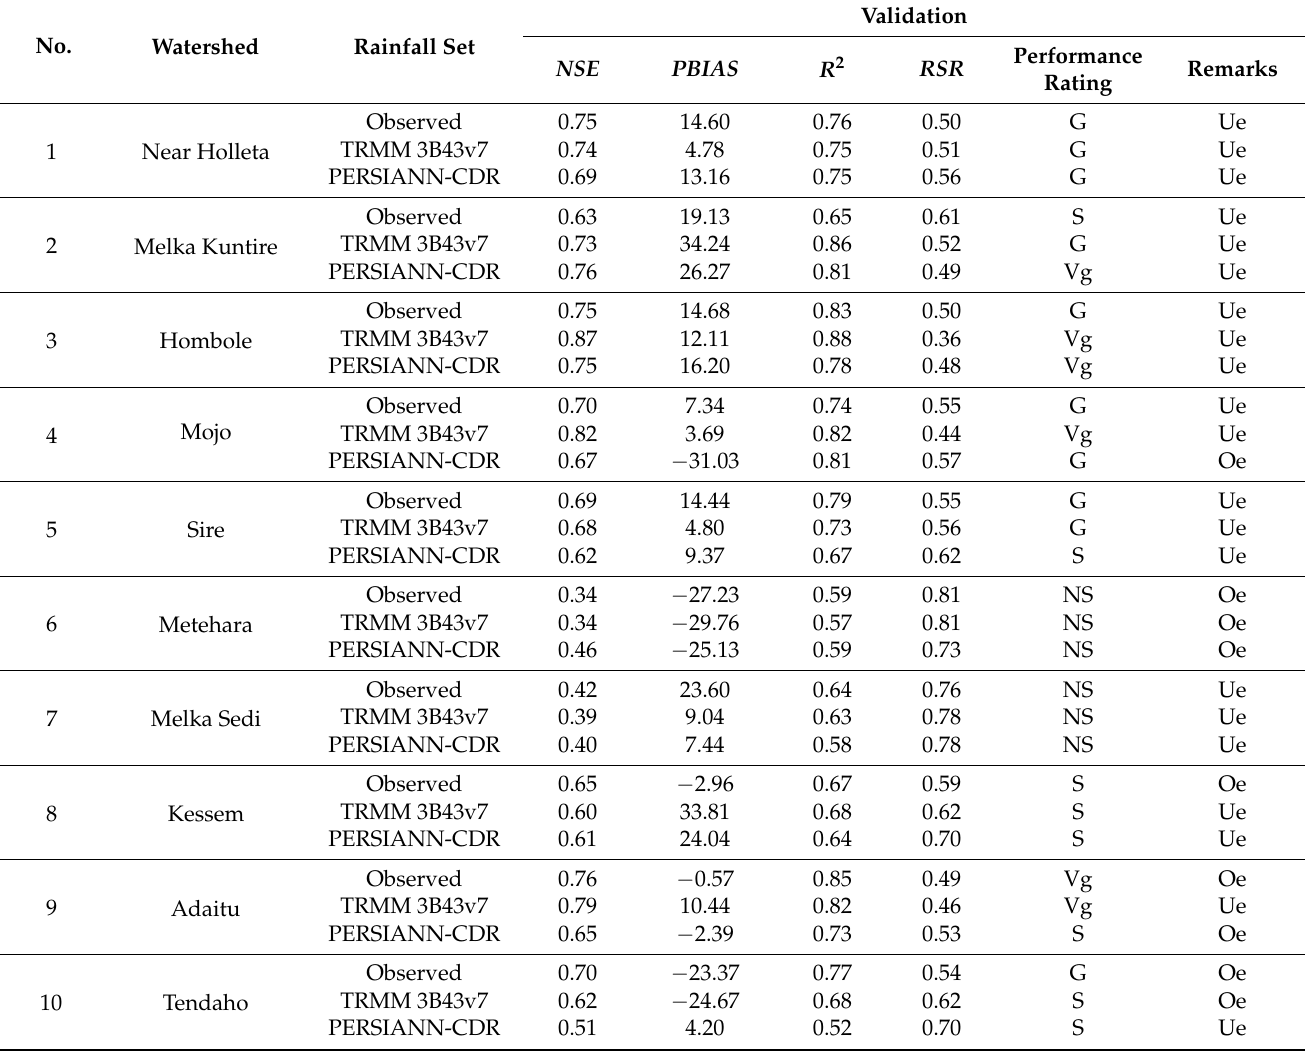
Table 5. Comparison of statistical evaluation criteria for validation of hydrologic